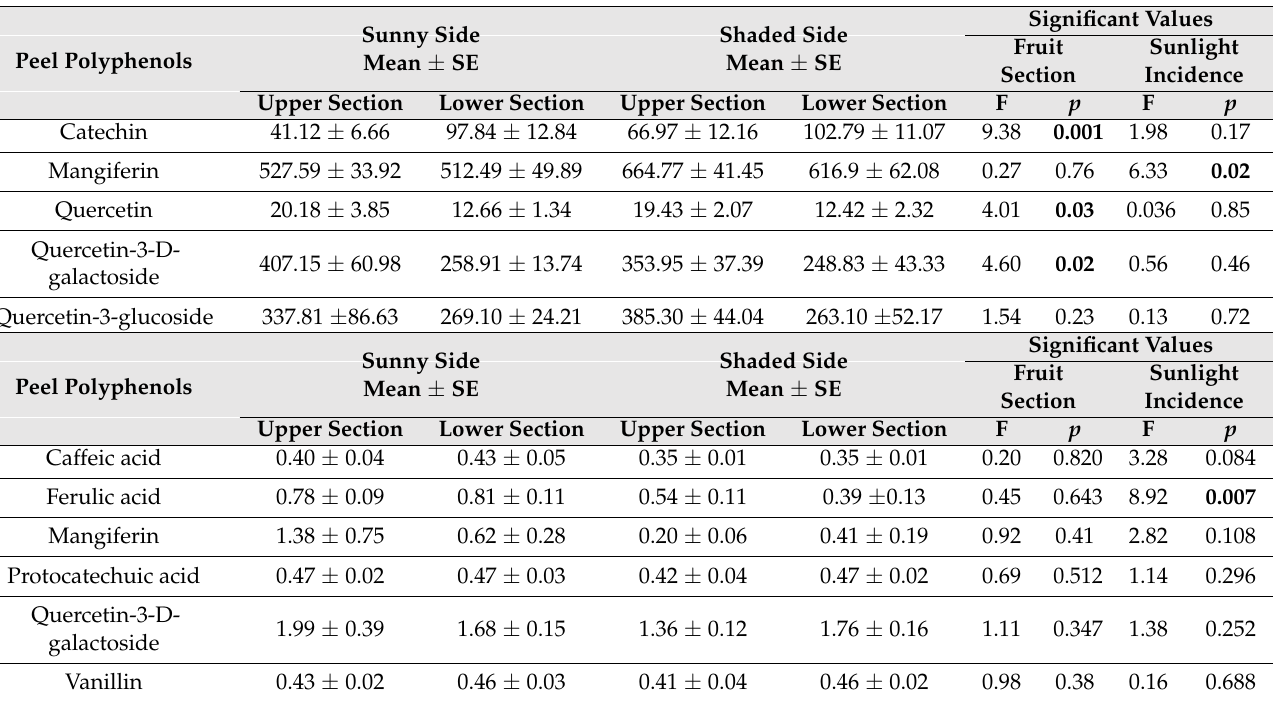
Table 2. Concentrations of polyphenols and significance values of factorial ANOVAs of peel and pulp polyphenols considering sunlight incidence and fruit section (upper vs. lower) as factors from “targeted metabolomic analysis of plant phenolic compounds study” in mangos not exposed to female oviposition activity. Data reported as the mean ± SE ( µ g/g).